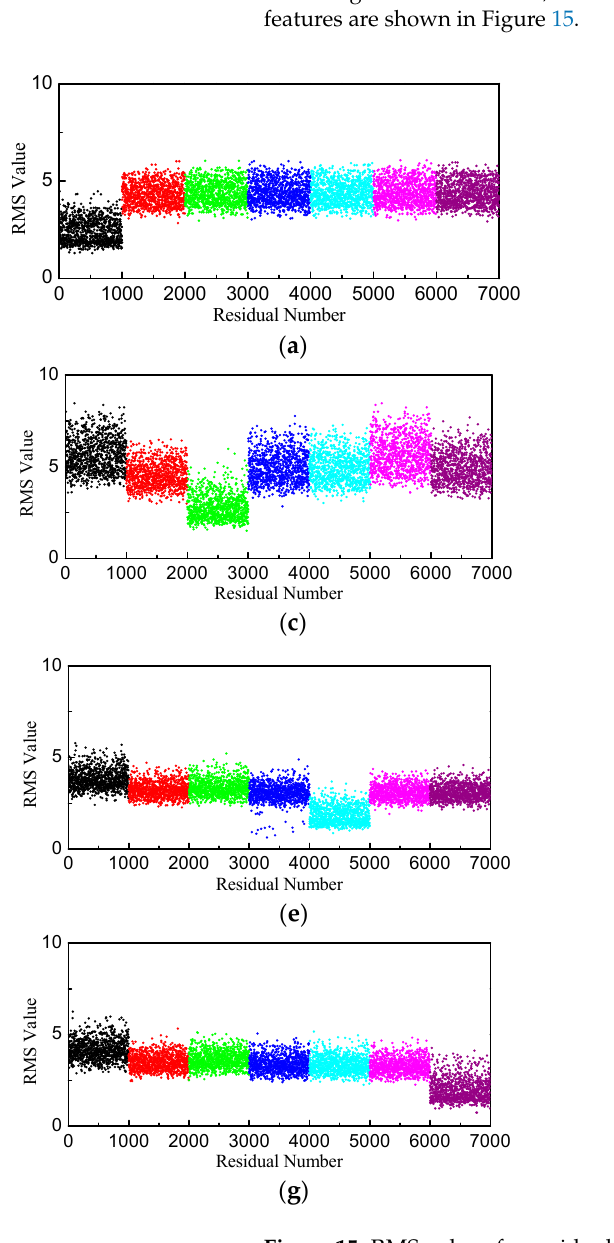
Figure 15. RMS values for residuals of different conditions using DWT-gained dictionaries, where point color corresponds to number of conditions. Results by dictionary learned from: ( a ) Condition 1; ( b ) Condition 2; ( c ) Condition 3; ( d ) Condition 4; ( e ) Condition 5; ( f ) Condition 6; ( g ) Condition 7.